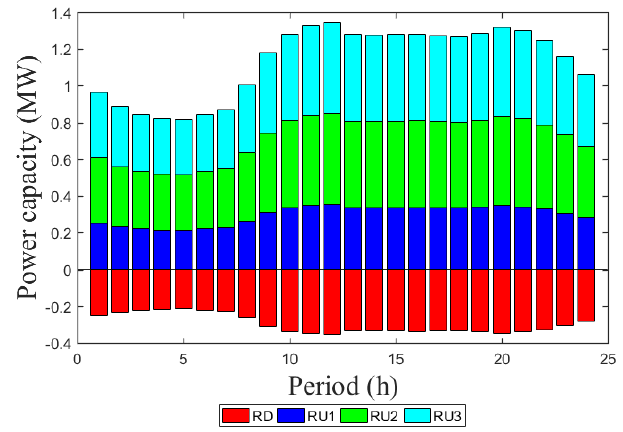
Figure 5. Reserve capacity scheduling at day-ahead stage.